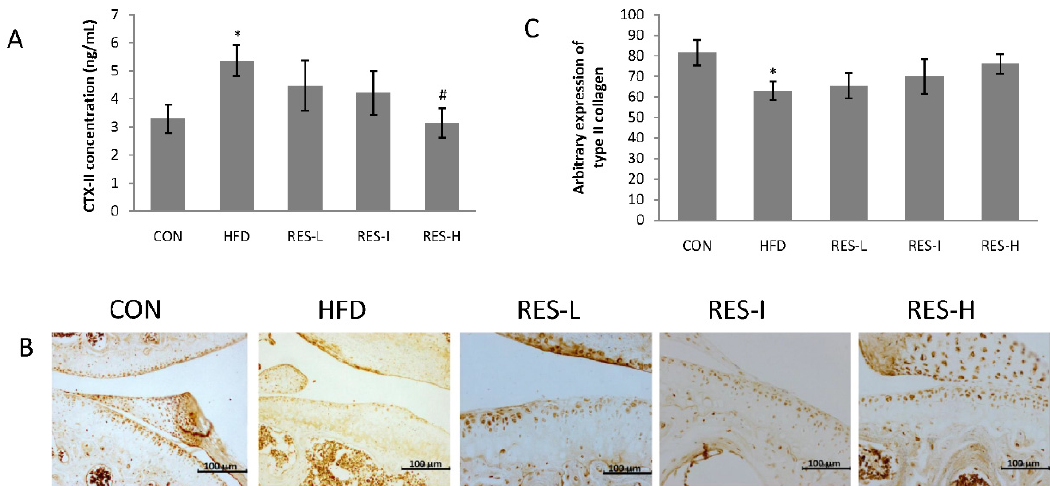
Figure 3. Effect of resveratrol on the degradation of type II collagen in knee articular cartilage. ( A ) Serum CTX ‐ II levels were measured after 12 weeks; ( B ) Representative sections of knee joints that were stained for type II collagen (original magnification, 200×). Scale bar = 100 μ m; ( C ) Histomorphometric measurements of type II collagen expression. Positive cells were defined based on type II collagen immunostaining. The whole cartilage areas were selected, quantified, and averaged. All data are expressed as the mean ± SE for 10 mice per group. ANOVA was used to test for statistical significance. * p < 0.05 versus the CON group and # p < 0.05 versus the HFD group.